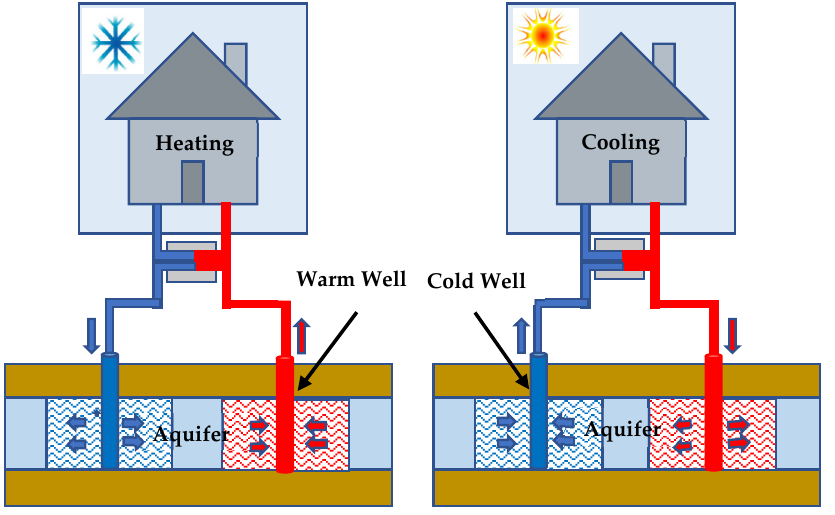
Figure 5. Schematic of an Aquifer Thermal Energy Storage (ATES).